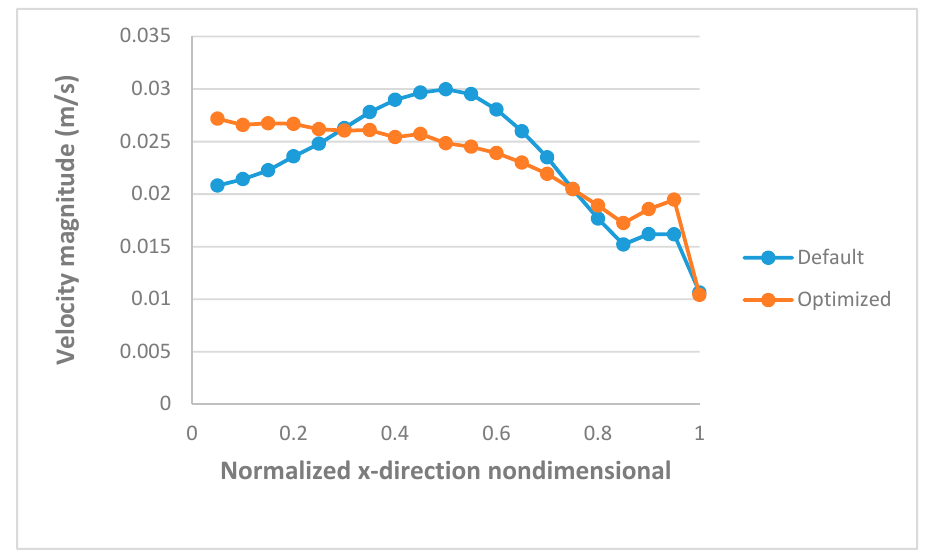
Figure 8. Comparison of velocity distribution in the initial and optimized dies.